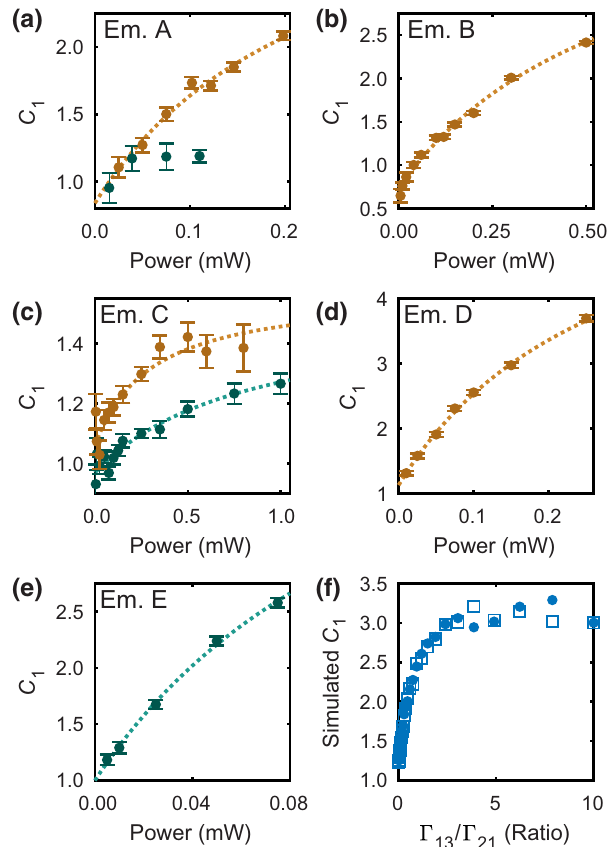
FIG. 12. Quantum emitter A: lifetime measurement. Time- resolved PL (light orange circles) and fit (dark orange circle) to the data. The error bars represent one standard